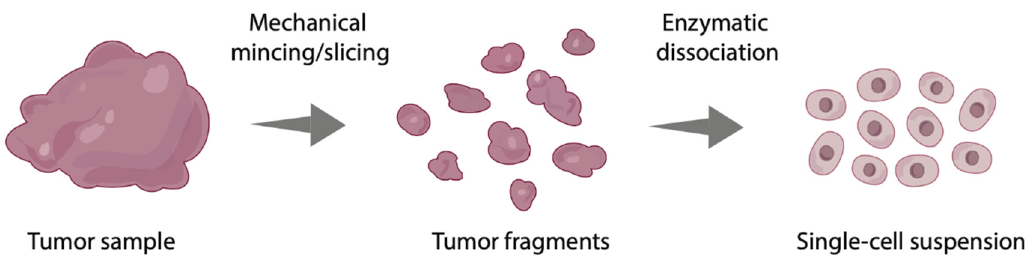
Figure 2. Processing of the primary tumor sample into tumor fragments by mechanical modification and subsequently into a single-cell suspension by enzymatic dissociation.